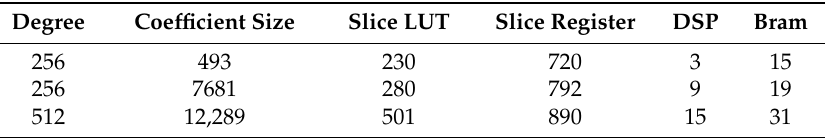
Table 3. Several implementations of Gaussian sampling on a Zybo